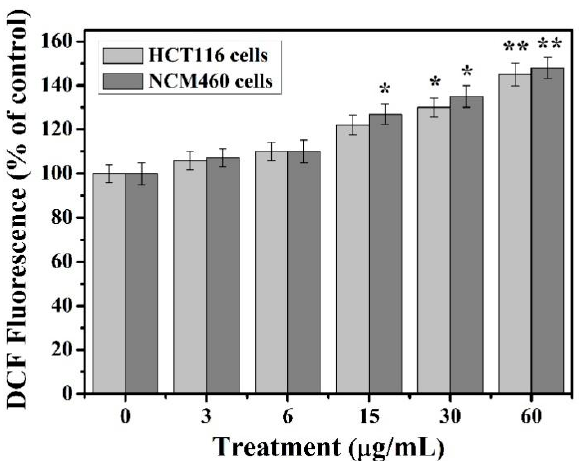
Figure 3. TiO 2 -NPs induces oxidative stress. The cells were treated with 3 to 60 µ g / mL of titanium dioxide NPs within 24 hours. The experiments were carried out in triplicate and data presented are in mean values, * indicates p < 0.05, ** indicates p < 0.01.